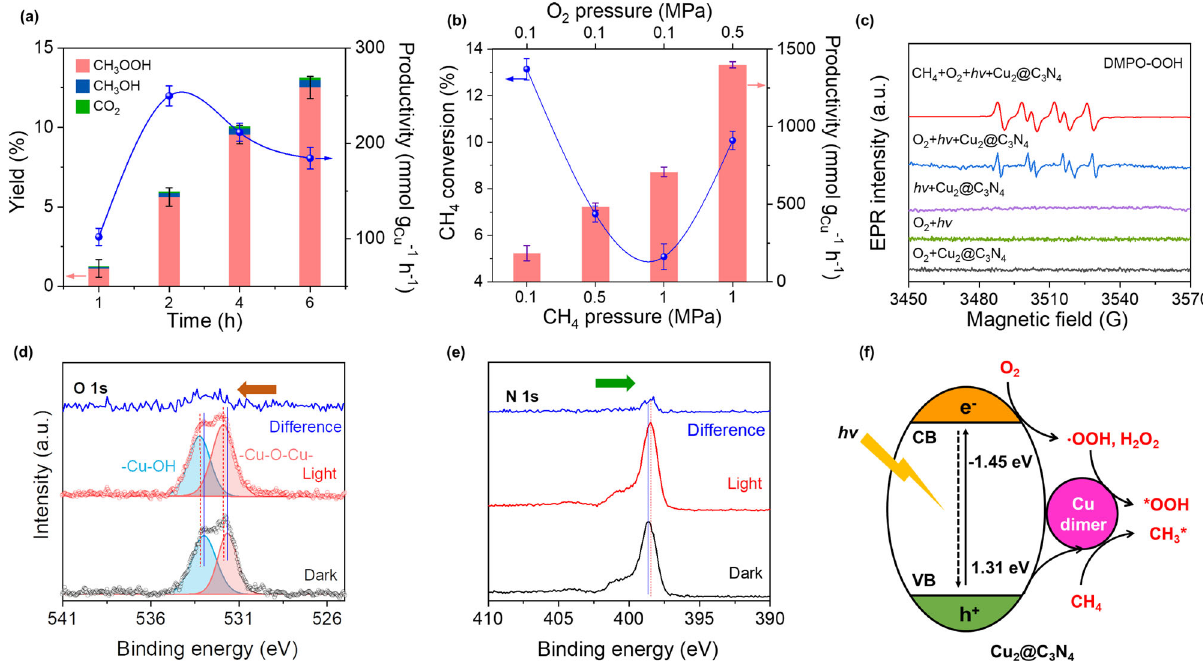
Fig. 4 Photo-catalytic oxidation of CH 4 with O 2 . a Yields and productivity of methyl oxygenates as a function of reaction time at 0.1 MPa CH 4 and 0.1 MPa O 2 . b CH 4 conversions and productivity of methyl oxygenates at different CH 4 and O 2 partial pressures. c EPR spectra recorded for various control experiments using DMPO as the radical trapping agent. d , e In situ irradiation XPS spectra collected at the O 1 s ( d ) and N 1 s ( e) edges. f Schematic illustration of the photocatalytic oxidation of CH 4 with O 2 catalyzed by Cu 2 @C 3 N 4 . The values “ − 1.45 and 1.31 eV ” label the estimated position of dicopper- oxo states in the band structure of g-C 3 N 4 , as determined by performing the UV-vis DRS and UPS spectra analysis of Cu 2 @C 3 N 4 . The error bars shown in ( a , b ) indicate the statistical distribution derived from three independent